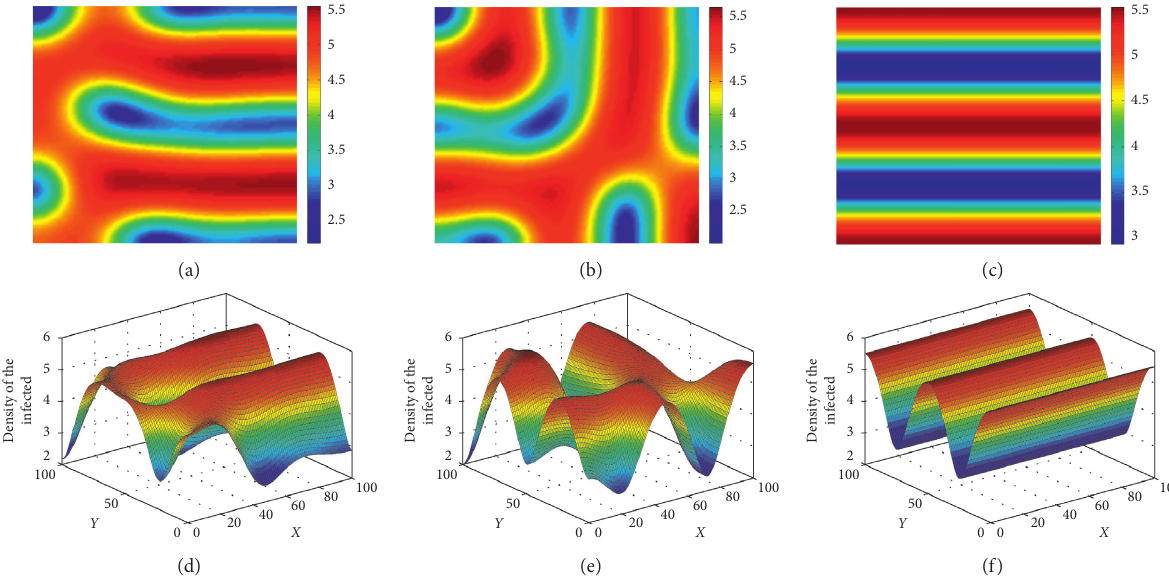
Figure 4: The first row shows stripe patterns with three different spatial structures in two-dimensional space for different time delay parameters: (a and d) τ � 0 . 1; (b and e) τ � 0 . 2; (c and f) τ � 0 . 3. These patterns are further presented in a three-dimensional space in the second row.